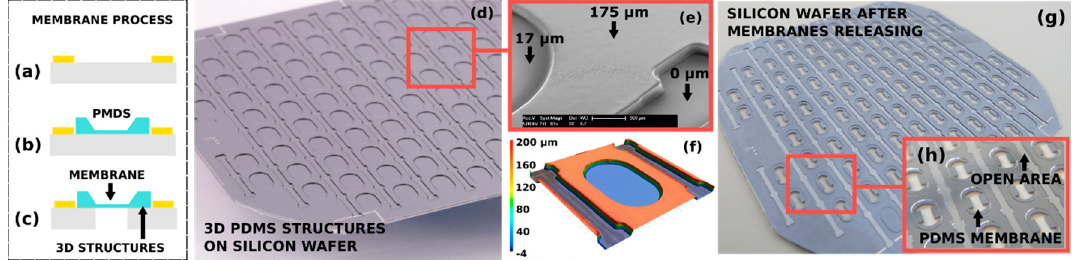
Figure 3. Process flow applied for the fabrication of a membrane: ( a ) a pre-processed wafer with metallic and polymeric structures presented in [4] is used, ( b ) PDMS is molded on top of the structures with the presented process and ( c ) the PDMS membrane released by etching the silicon under the PDMS with DRIE. ( d , e ) Silicon wafer with 3D PDMS molded structures customized for the Heart-on-Chip presented by Gaio et al. [4]. The topographies and the thickness of the PDMS layer were analyzed and measured with SEM images ( f ) and Laser Scanner. The process allowed forming structures with different heights in a single step (ranging between 17 µm and 175 µm). Moreover, designated areas of the wafer are left completely clean from PDMS, thus avoiding any etching step. ( g , h ) Suspended PDMS areas/membranes were then released by locally etching the silicon from the back of the wafer with deep-reactive ion